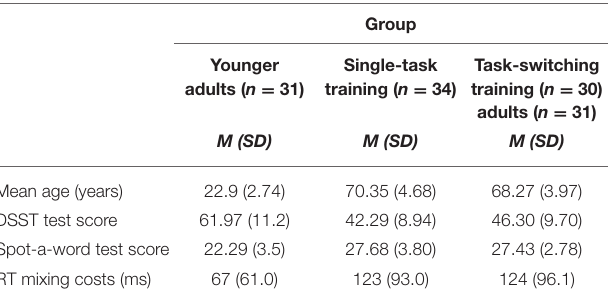
TABLE 1 | Characteristics of the sample and baseline measurement of cognitive tasks at